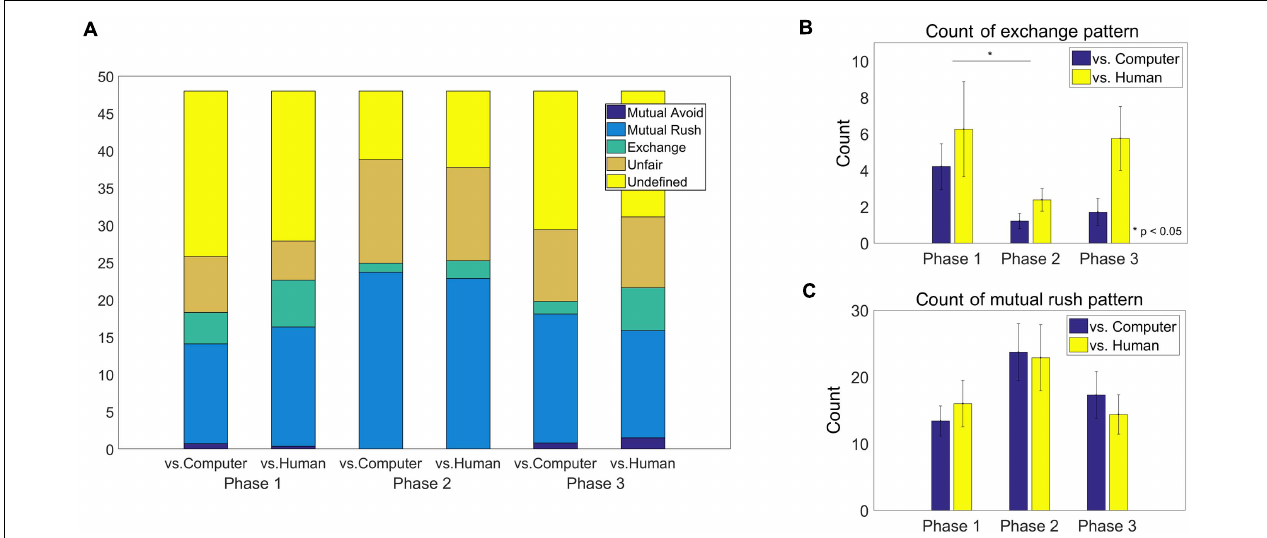
FIGURE 5 | (A) The average count of behavioral pattern categories of each group in each phase. The four categories of behavioral patterns includ the mutual avoid, mutual rush, exchange and unfair patterns (see text for details). Behavioral patterns other than these categories were marked as undefined. (B) The average frequency of the exchange pattern of each group in each phase. There was a significant difference in count between two groups ( p = 0.0329) and between the first phase and the second phase ( p = 0.0374). (C) The average frequency of the mutual rush pattern of each group in each phase. There was a main effect of the phase ( p =